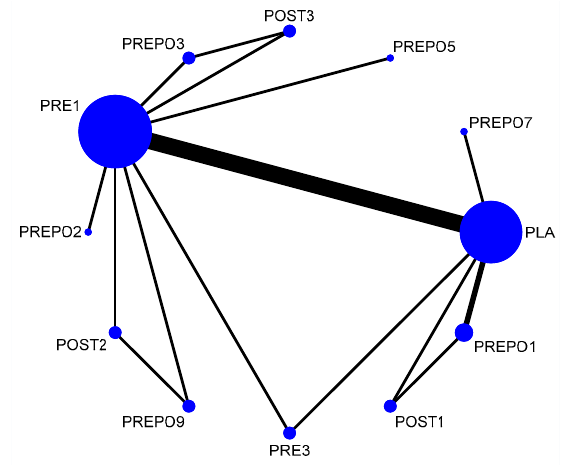
Figure 2. Network plot: implant failure (per patient). Abbreviations: PLA = placebo/no antibiotics;